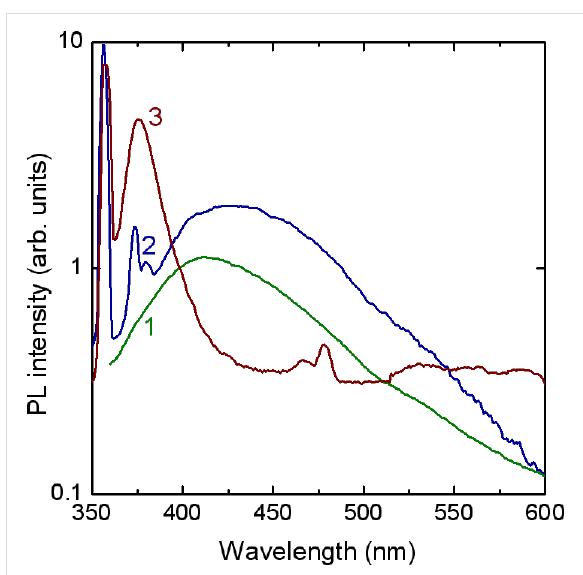
Figure 3: PL spectrum of methanol (1), PVP (2) and colloidal ZnO/PVP/methanol (3) at 300 K (Sample 1).